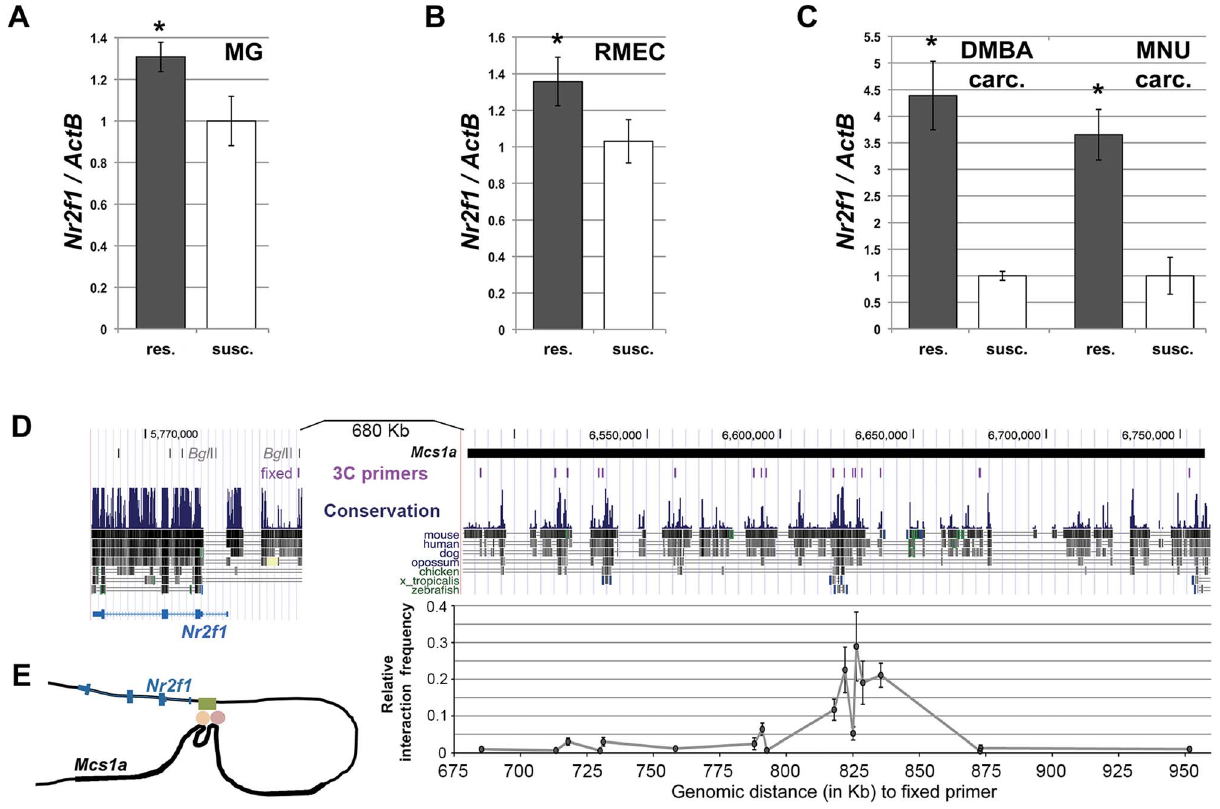
Figure 3. The non-protein coding Mcs1a resistance locus regulates transcript levels of Nr2f1 in the mammary gland, mammary epithelium and mammary carcinomas. A–C) Q-PCR analysis of Nr2f1 transcript levels in mammary gland (MG; panel A), rat mammary epithelial cell (RMEC, panel B) and DMBA- or MNU-induced mammary carcinoma (carc.; panel C) samples from resistant congenic (res.; n=54 panel A, n=18 panel B, n=12 each panel C) and WF.Cop susceptible congenic control (susc.; n=19 panel A, n=11 panel B, n=6 each panel C) rat lines. Data derived from both the W4 and W5 congenic lines are used in the Mcs1a resistant congenic data points. Nr2f1 transcript levels are shown relative to the transcript level of the ActB endogenous control gene. D) Chromosome conformation capture (3C) assay for the Nr2f1 promoter and the Mcs1a critical interval. The region is shown as a UCSC Genome Browser view (version rn4 of rat genome) and the location of the Mcs1a critical interval in indicated as a horizontal black line. The evolutionary sequence conservation track is also shown. The locations of the 3C assay primers are shown as vertical purple lines. The fixed primer in the Nr2f1 promoter is shown with respect to Bgl II restriction sites in the Nr2f1 gene span. Graphed is the average relative interaction frequency ( + / 2 sem) of the Bgl II fragment in the Nr2f1 promoter containing the fixed primer with each of the Bgl II fragments in Mcs1a containing the 3C assay primers (n=4 or more templates). Significantly increased relative interaction frequency is indicated with 1 asterisk for a background cut-off interaction frequency of 0.05 and 2 asterisks for a background cut-off interaction frequency of 0.1. The horizontal axis indicates the genomic distance (in Kb) from the 3C assay primers in Mcs1a to the fixed primer in the Nr2f1 promoter. The main peak in the interaction profile coincides with blocks of strong evolutionary sequence conservation (to zebrafish and frog, X. tropicalis ). Sequence variation within the interacting Mcs1a region is outlined in Figure S2. E) Schematic drawing of the higher-order chromatin interaction of Mcs1a with the Nr2f1 promoter. The Mcs1a critical interval is indicated as a thick area in the black line that represents the DNA. The green, orange and red shapes represent the putative DNA- binding proteins involved in the structure.